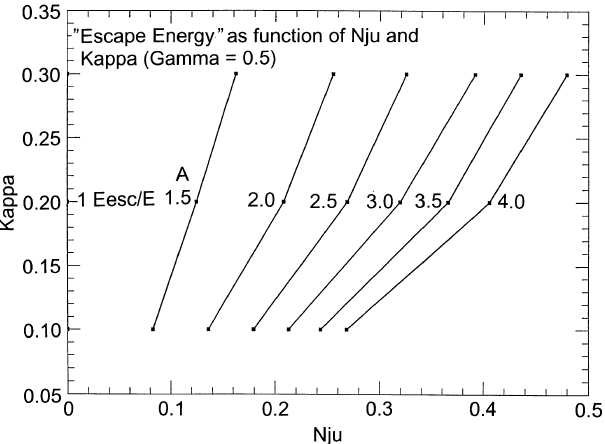
Fig. 11. The escape energy as a function of (cid:109) (cid:3) and (cid:106) for (cid:99) (cid:136) 1 = 2 : The calculated points are joined by straight lines . The numbers in the centre row refer to the escape energy expressed in terms of the threshold energy of the corresponding undamped